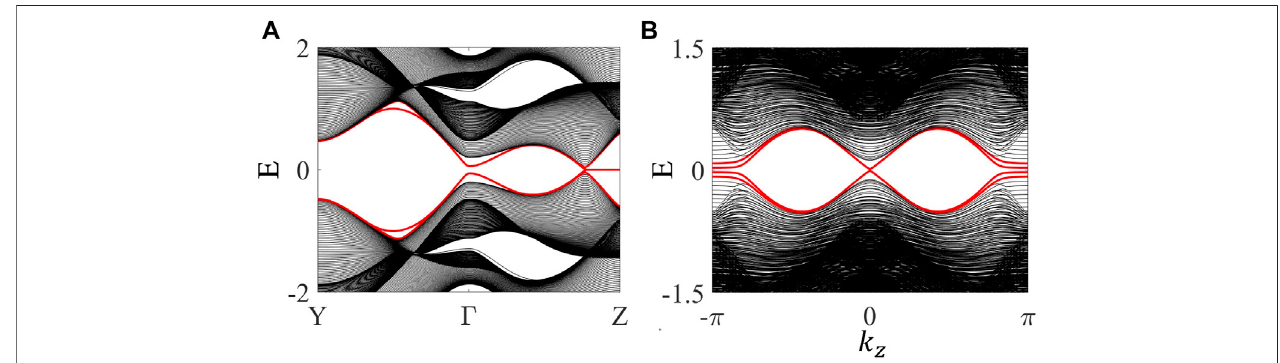
FIGURE 8 | (Color online) Hybrid-order Weyl semimetal phases. Chosen parameters are: t = 1, t z = 0.5, m = 1.6, λ = 1, η = 0.2. (a) The energy spectrum is for a geometry with open boundary condition in the x direction ( N x = 100) and periodic boundary conditions in both the y and z directions. The energy spectrum is plot along two high symmetry lines in the surface Brillouin zone. Y , Γ , Z denote the time-reversal invariant momentums ( k y , k z ) = ( π , 0) (0, 0) (0, π ), respectively. The zero-energy fl at bands in red in (A) indicate the appearance of surface Fermi arcs on the x -normal surfaces. (B) The energy spectrum for a geometry with periodic boundary conditiononlyinthe z direction.Thesystemsizeinthe x and y directionsis N x = N y =20.Thecrossingofthered linesat k z =0isamanifestationoftheexistence ofhelical hinge states.